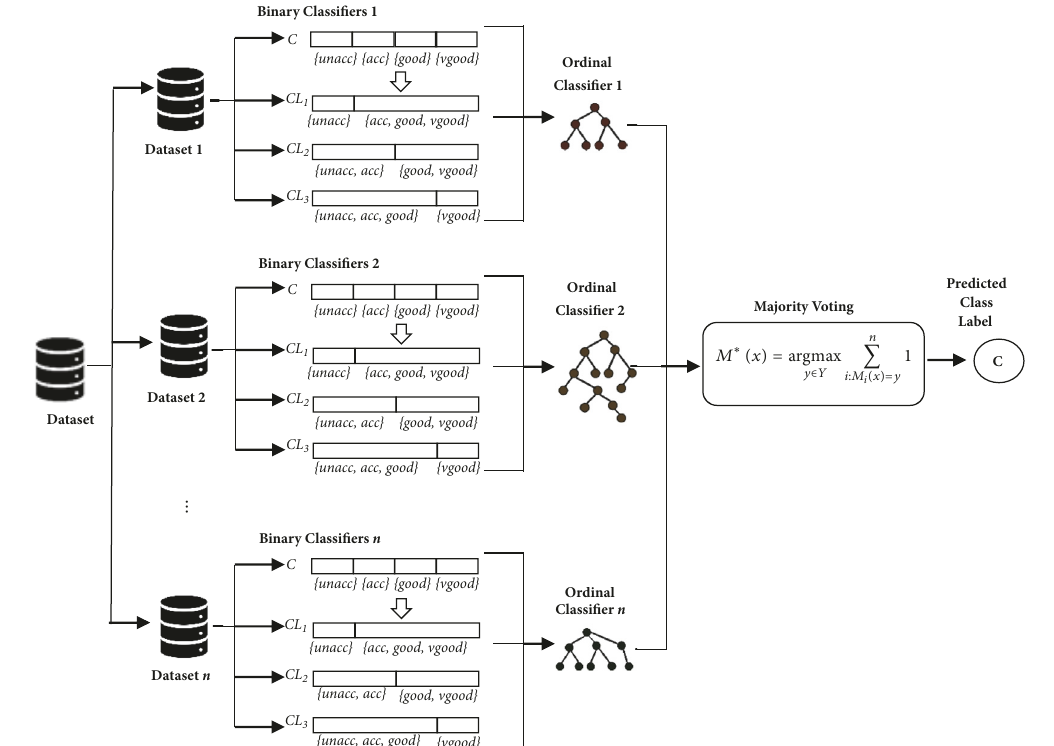
Figure 3: The general structure of the proposed approach